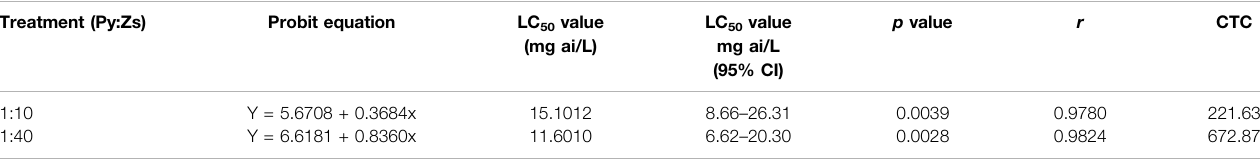
TABLE4| Determinationofthecotoxicitycoef fi cientofpymetrozineandzhongshengmycinonthirdinstarnymphsof N.lugens andstatisticalresultsoftheadjustmenttothe log-probit model under greenhouse condition. Treatment (Py:Zs) Probit